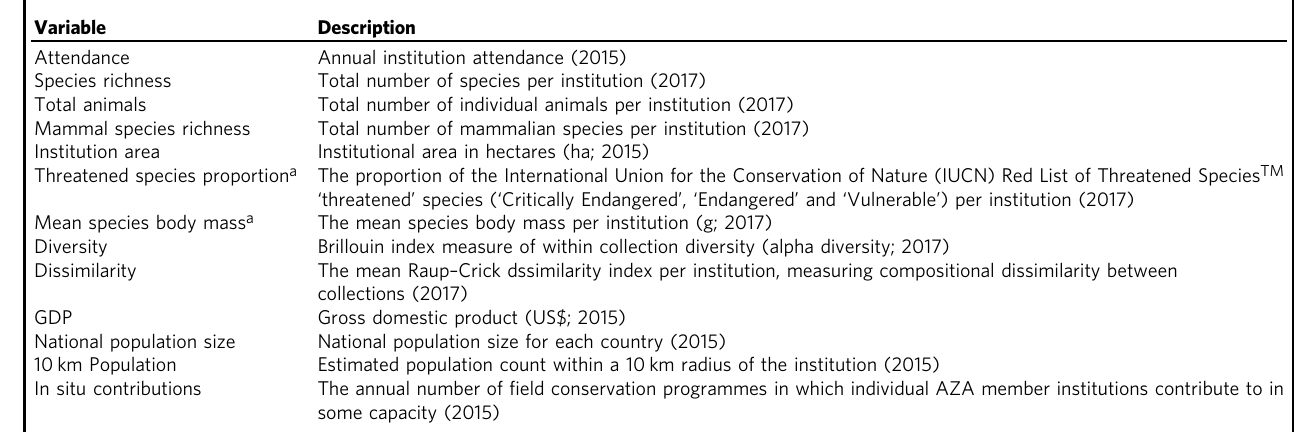
Table 1 Description of the variables used within the structural equation